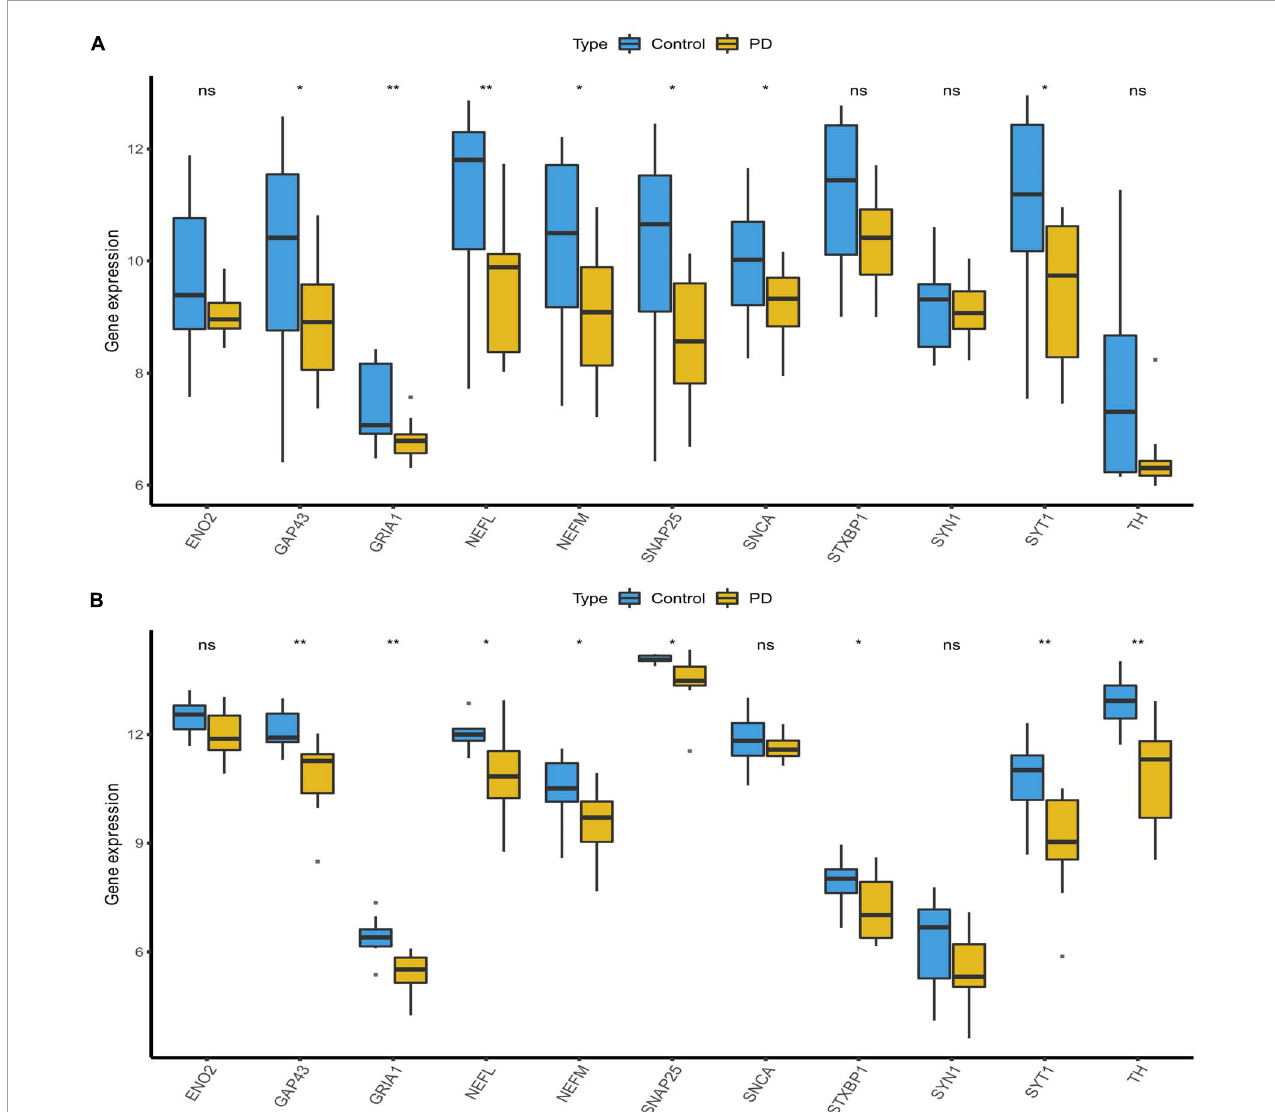
FIGURE6 Validation of candidate hub genes. (A) Validation of candidate hub genes in the GSE20292 dataset. (B) Validation of candidate hub genes in the GSE20681 dataset (* p < 0.05, ** p < 0.01). PD, Parkinson’s disease.